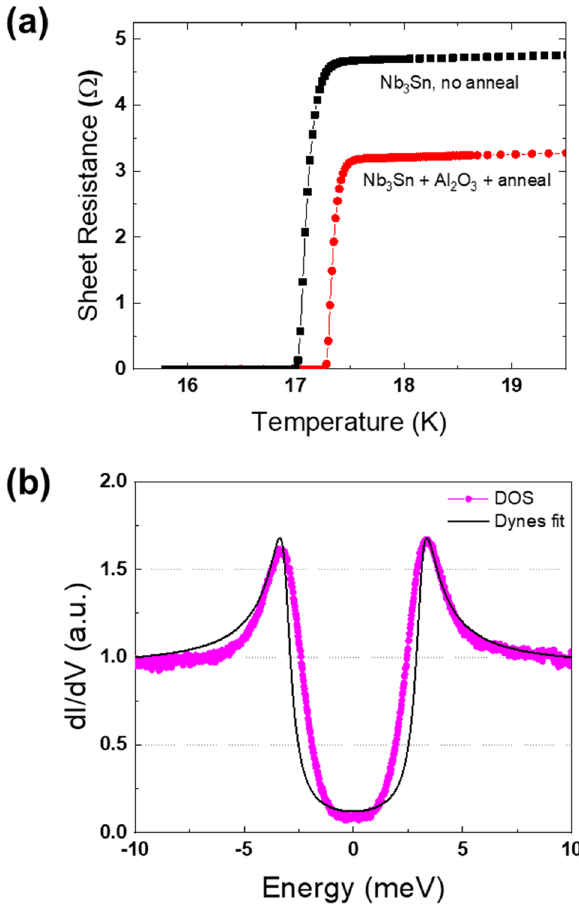
Figure 5. Superconducting properties of single-layer Nb 3 Sn films. ( a ) Resistive superconducting transition for two identical 60 nm thick films, one of which is capped with 6 nm Al 2 O 3 overlayer and annealed at 900 °C for 10 min. ( b ) Density of states measured by scanning tunneling spectroscopy and Dynes fit for a 60 nm thick Nb 3 Sn